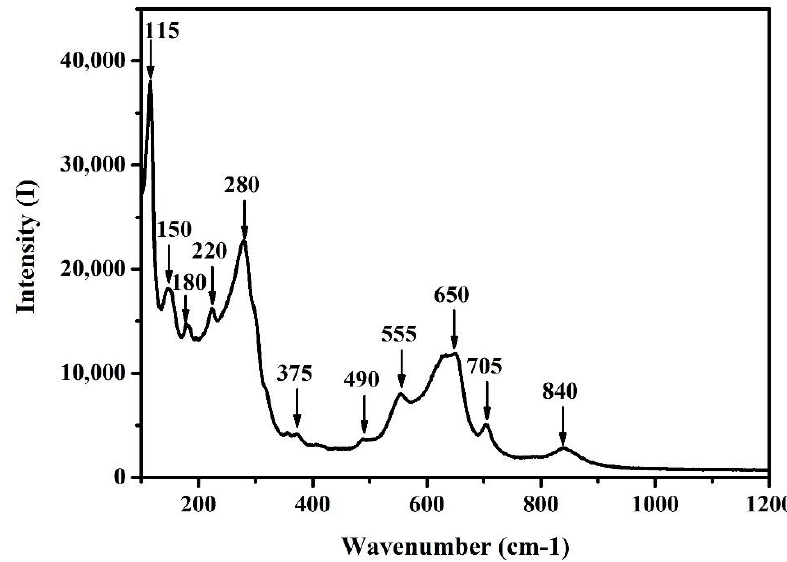
Figure 3. Raman spectra of Ba 0.54 Na 0.46 Nb 1.29 W 0.37 O 5. Table 4. Attributed Raman bands of the Ba 0.54 Na 0.46 Nb 1.29 W 0.37 O 5 within the frequency range 1200 – 100 cm −1 .